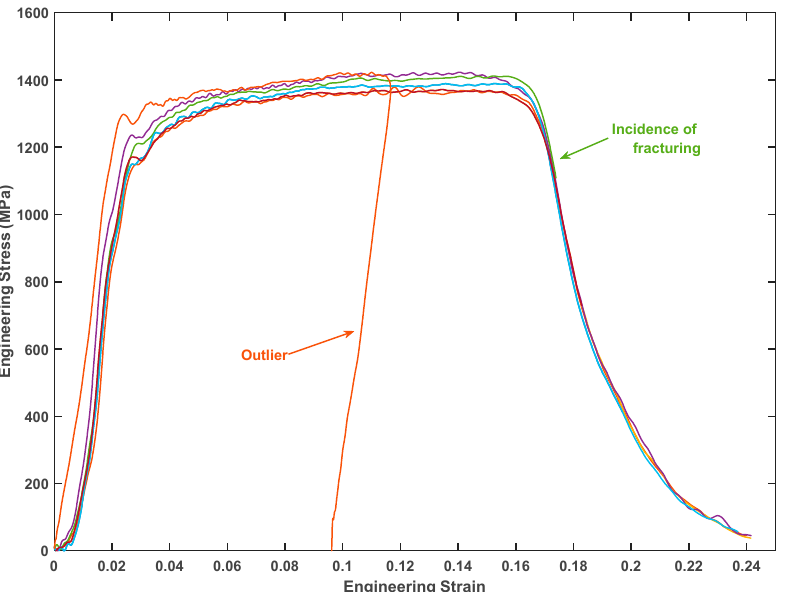
Figure 7. Stress–strain curves for the six SR specimens of 6 mm length, tested at a strain rate of approximately 400 s − 1 .